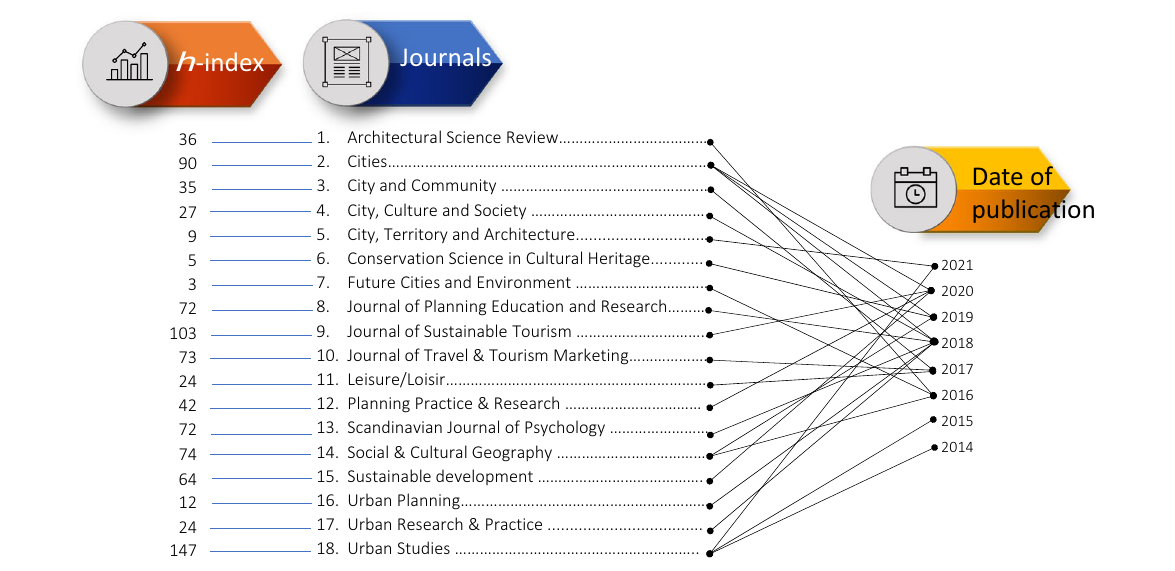
Fig. 1 Eighteen journals between 2014 and